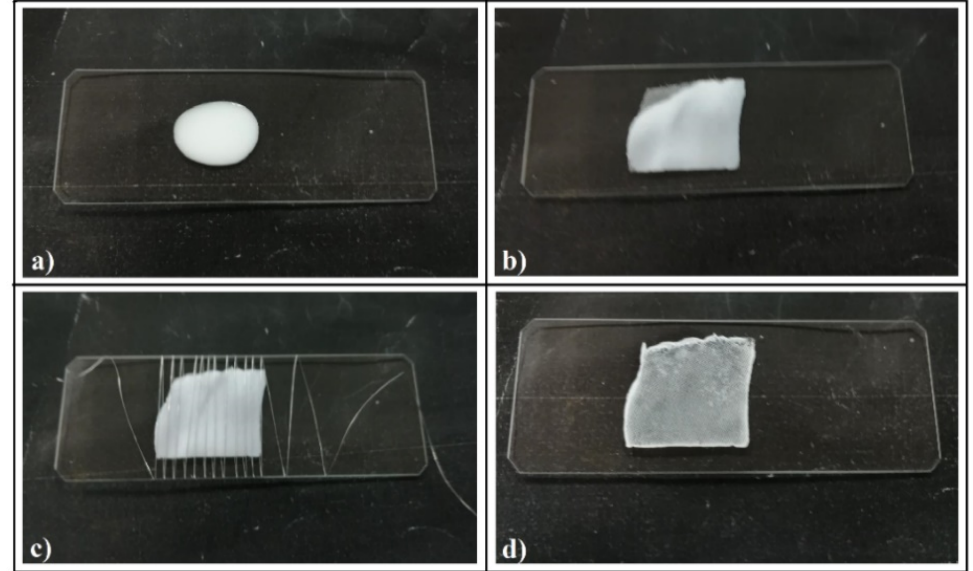
Figure 1. Experimental set-up and the necessary steps for synthesis of colloidal crystal self-assembly guided by polyester fabric: ( a ) colloidal solution drop on the microscope glass slide substrate; ( b ) polyester fabric pressing the colloidal drop; ( c ) metallic wire rolled around the fabric and the colloidal film; ( d ) the final dried PCCs after the wire and the fabric were removed.